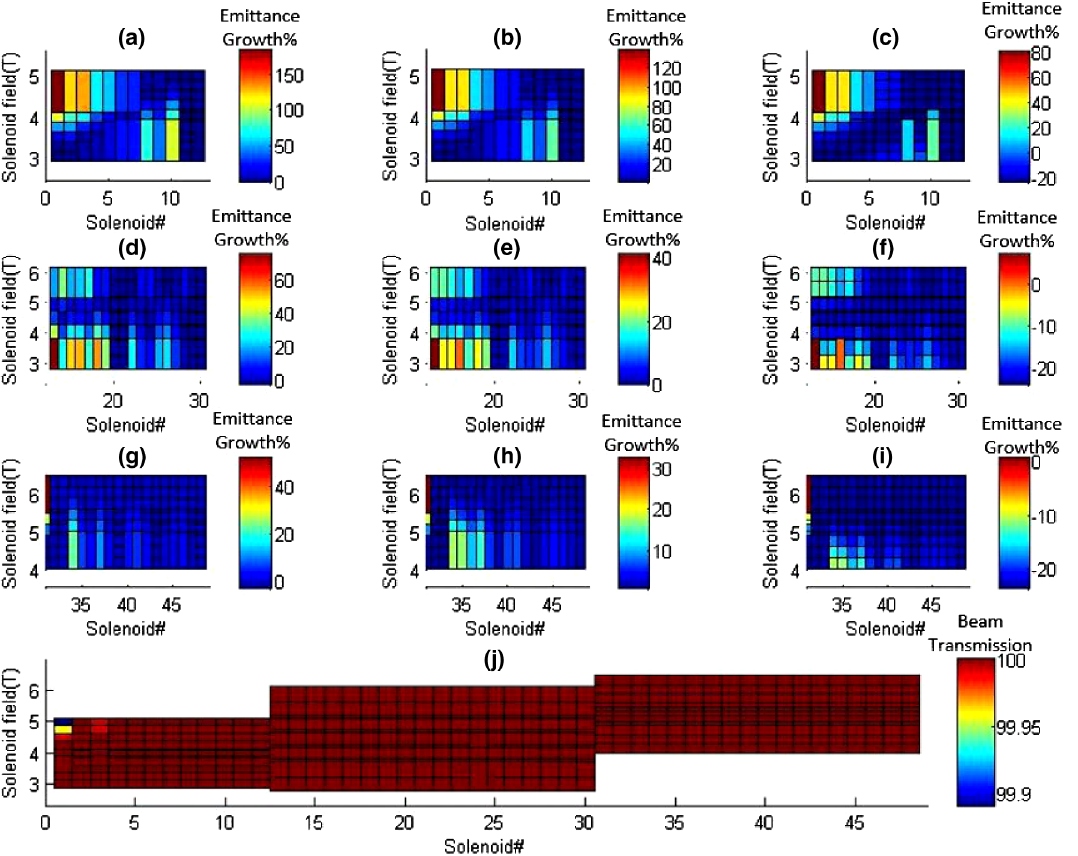
FIG. 44. (a),(b),(c) variation of X, Y, and Z emittance as a function of solenoid field for SSR-A; (d),(e),(f) variation of X, Y, and Z emittance as a function of solenoid field for SSR-B; (g),(h),(i) variation of X, Y, and Z emittance as a function of solenoid field for SSR-C; (j) beam transmission as a function of solenoid field in the SSR-A, SSR-B, and SSR-C sections of the